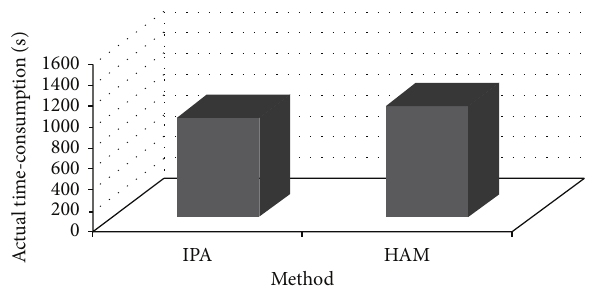
Figure10:Theactualtime-consumptionforeachprioritizationtask, derived from start/end times recording automatically by TIPA and CHAM.